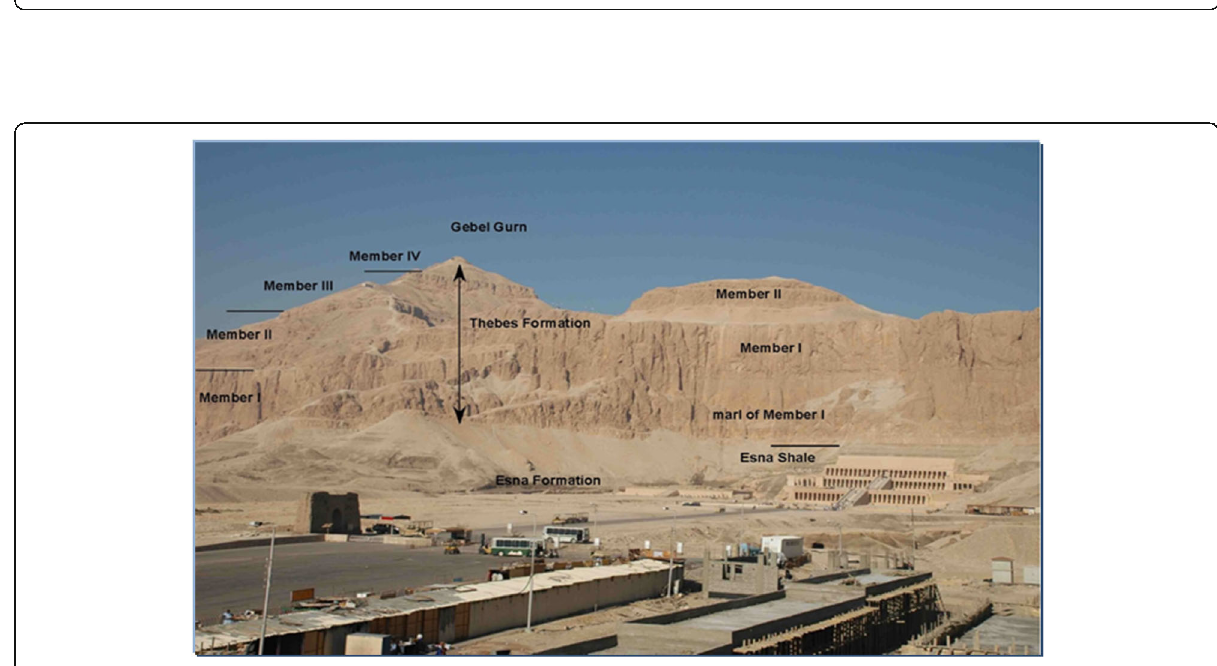
Fig. 6 Thebes Formations, Valley of the Kings, Luxor, Egypt. Gebel El-Gurnah is located some 4 km to the west of the River Nile, opposite to Luxor. The main exposed rock units in Gebel El-Gurnah are the Esna Shale and Thebes limestone formations. The tombs of the kings were excavated in the Thebes formations at northern side of Gebel El-Gurnah and the tombs of the queens were excavated at the southern